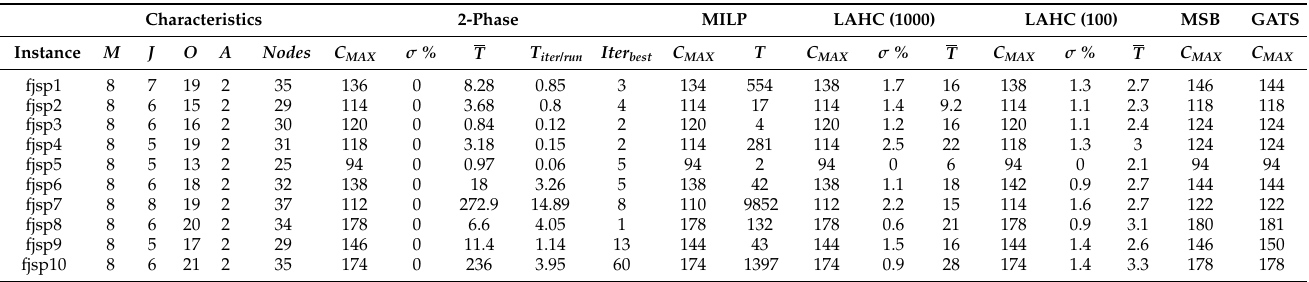
Table 3. Performance comparison of two-phase heuristic with existing approaches on Deroussi and Norre [4] test